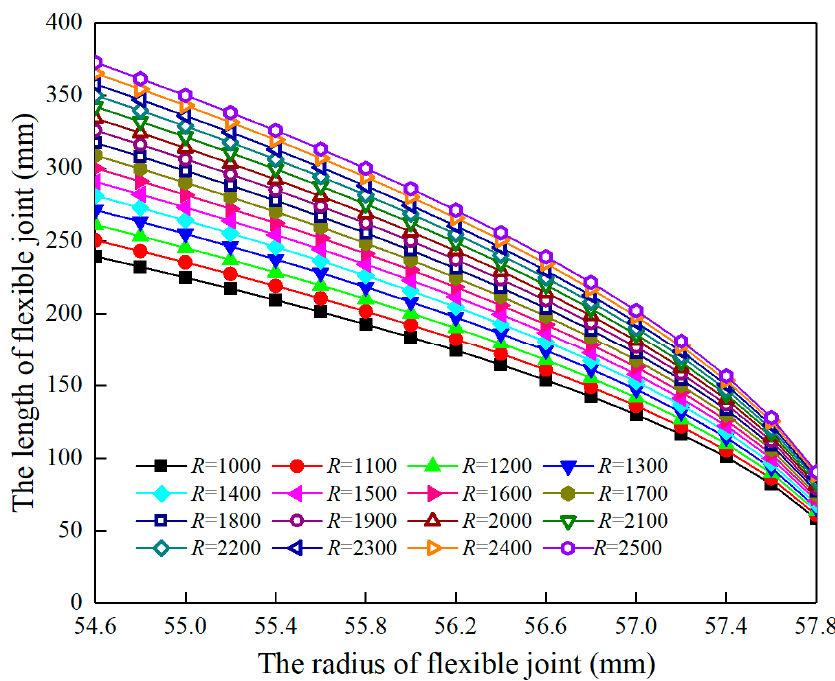
Figure 15. Variation curve of length of flexible joint with different radii.